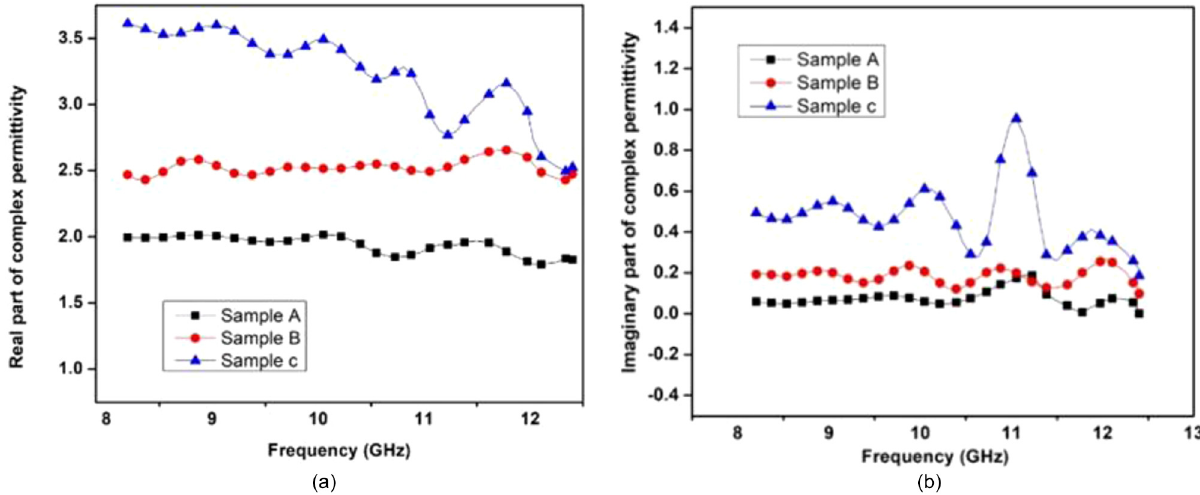
Fig. 3. Complex permittivity of RGO-SiC-LLDPE composite; (a) real permittivity and (b)